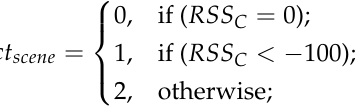
, A P , A P ) of the proposed 2 3 1